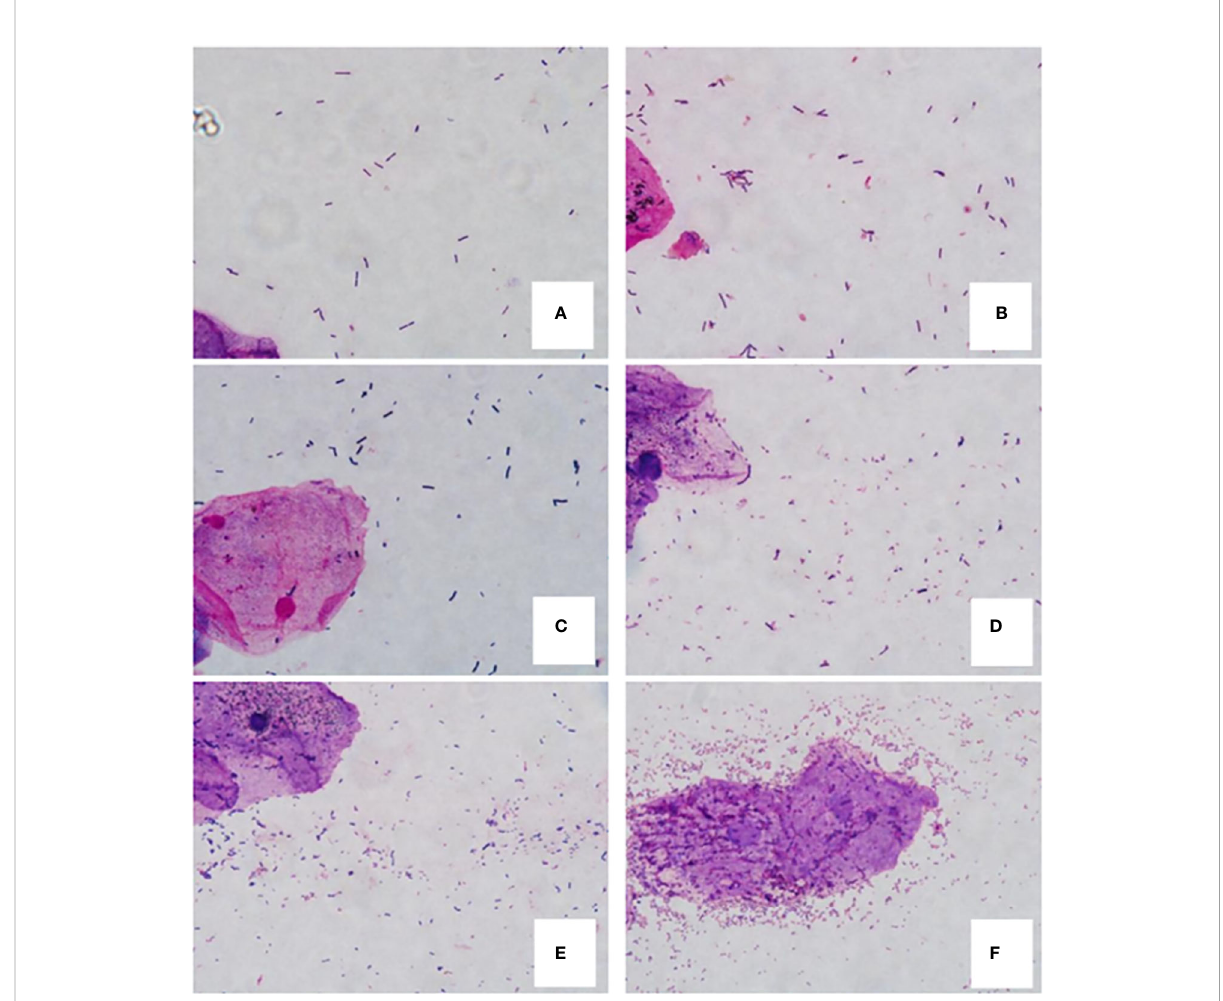
FIGURE 1 Gram-stained vaginal smears from women. (A, B) are normal fl ora samples. (A) 0 score (4+ Lactobacillus morphotypes, no small gram-negative or gram-variable rods), (B) 2 score (4+ Lactobacillus morphotypes, 2+ small gram-negative or gram-variable rods); (C, D) are mild dysbiosis vaginal fl ora samples. (C) 4 score (3+ Lactobacillus morphotypes, 3+ small gram-variable rods), (D) 6 score (2+ Lactobacillus morphotypes, 4+ small gram-negative and -variable rods); E and F are sever dysbiosis vaginal fl ora samples. (E) 7 score (3+ Lactobacillus morphotypes, 4+ gram- negative and -variable rods), (F) 10 score (no lactobacilli and 4+ gram-negative rods and curved rods, clue cell is in the center of fi